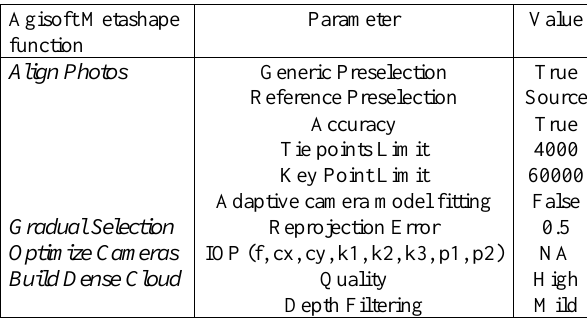
Table 1 . Agisoft Metashape processing parameters used in a typical photogrammetric workflow. NA - Not Applicable Therefore, a Digital Surface Model (DSM) was generated